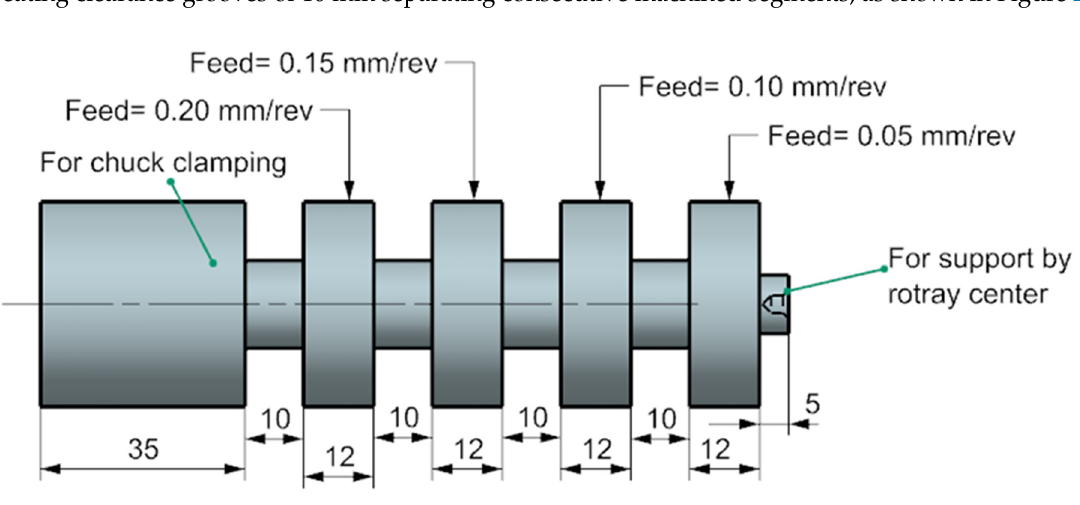
Figure 2. A schematic of the test specimen prepared for turning tests.